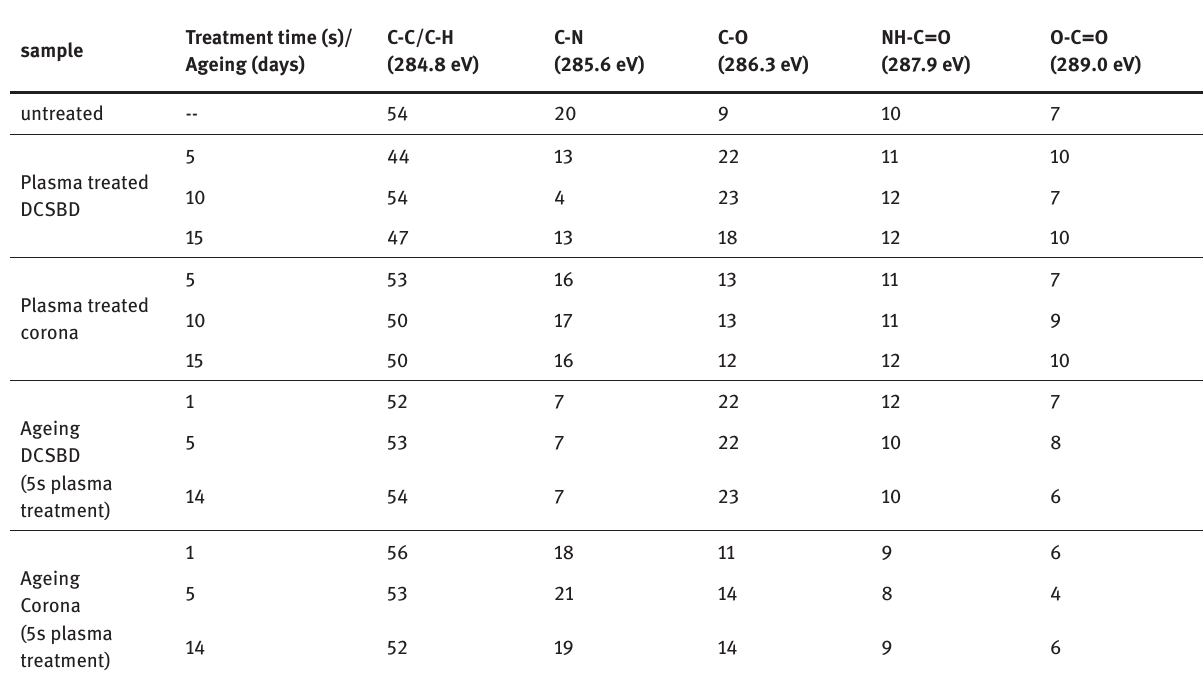
Relative area corresponding to different chemical bonds (%)